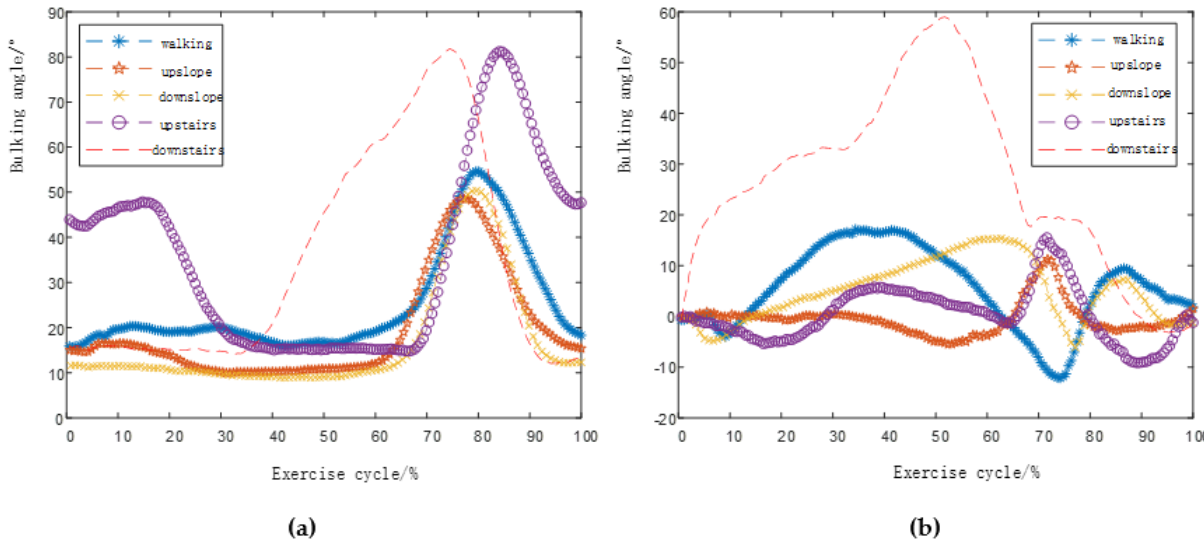
Figure 6. Five gait joint angle changes under time unification. ( a ) Knee joint angle change diagram, ( b ) Ankle joint angle change diagram.